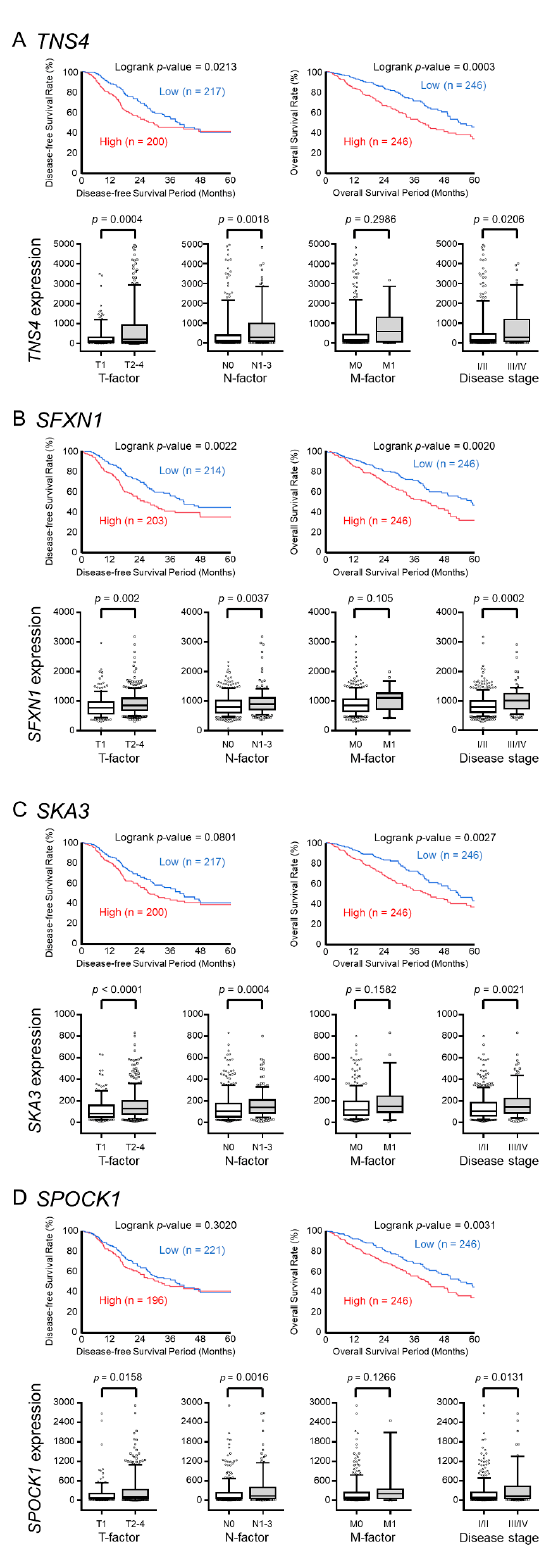
Figure 3. The relationship between the expression levels of four genes ( TNS4 , SFXN1 , SKA3 , and SPOCK1 ) and clinical significance based on The Cancer Genome Atlas (TCGA) database. ( A – D ) The Kaplan–Meier disease-free survival curves and overall survival curves, T factor, N factor, M factor, and disease stage of the high- and low-expression groups for four genes ( TNS4 , SFXN1 , SKA3 , and SPOCK1